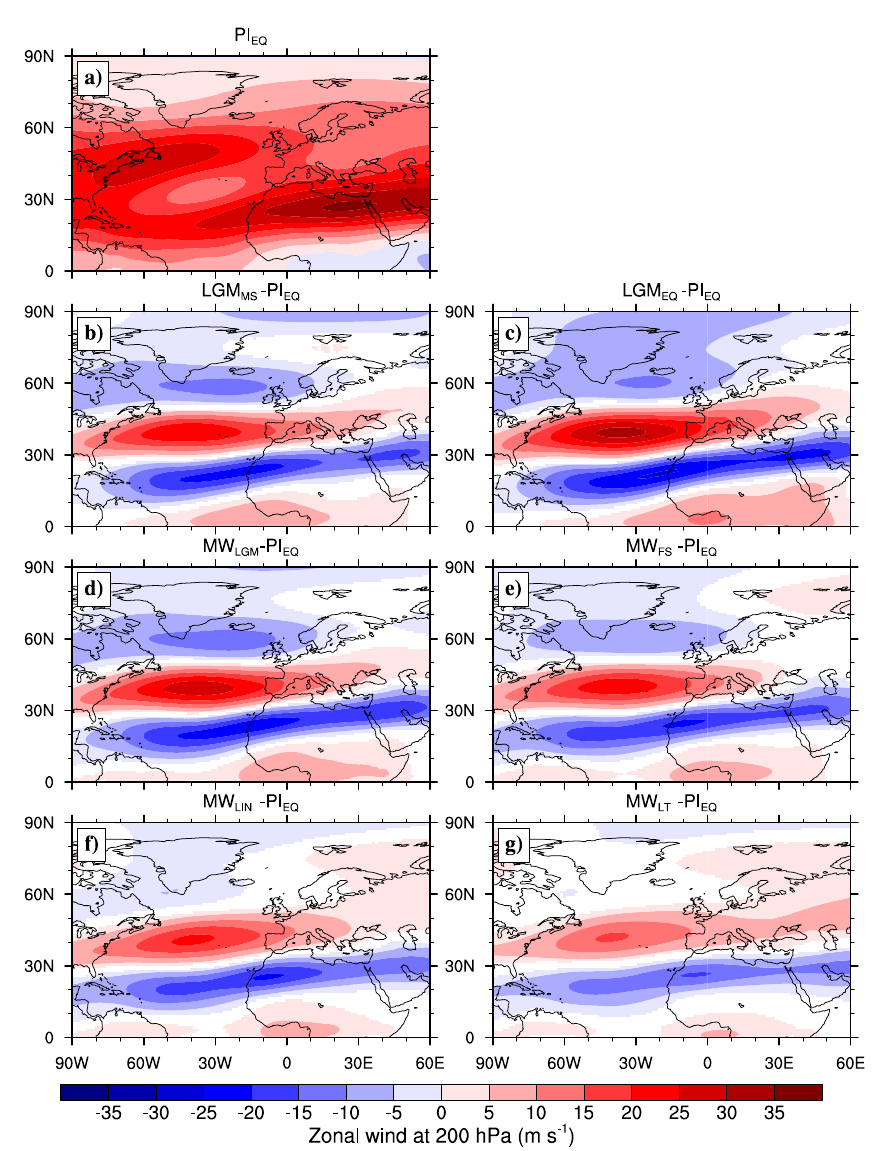
Fig. 8. Zonal wind at 200hPa for DJF. The mean value for PI EQ are shown in (a) while in (b–g) the anomalies of the different glacial simulations with respect to PI EQ are presented. For the anomalies only values that are statistically significant at the 5% level based on the Fig. 9. Zonal wind at 200 hPa for DJF. The mean value for PI are shown in (a) while in (b)–(g) the anomalies EQ two-sided Student’s t-test are of the different glacial simulations with respect to PI are presented. For the anomalies only values that are EQ statistically significant at the 5 % level based on the two-sided Student’s t test are colored.